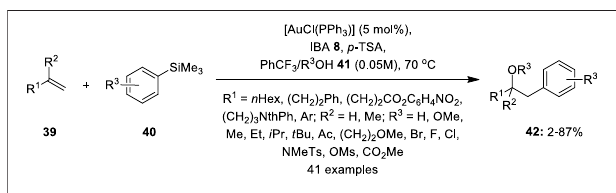
FIGURE 5 | Gold-catalyzed oxyarylation of mono- and gem-di- substituted ole fi ns 39 using IBA 8 as an oxidant.